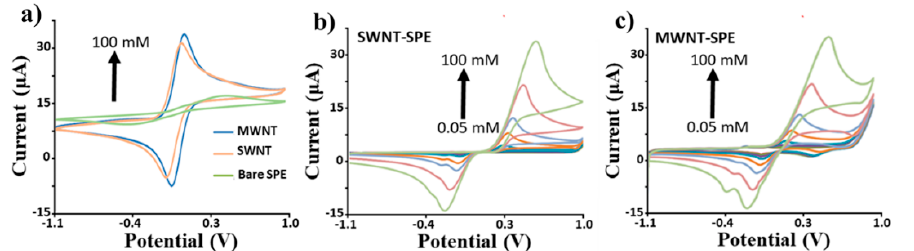
Figure 5. Comparison of the cyclic voltammograms; (a) simultaneous determination of the 3 ana- lytes; (b–d) PF, HQ, and BQ were analyzed separately.